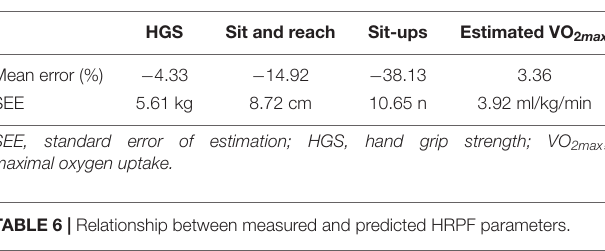
TABLE 5 | Validity of estimating the regression model.